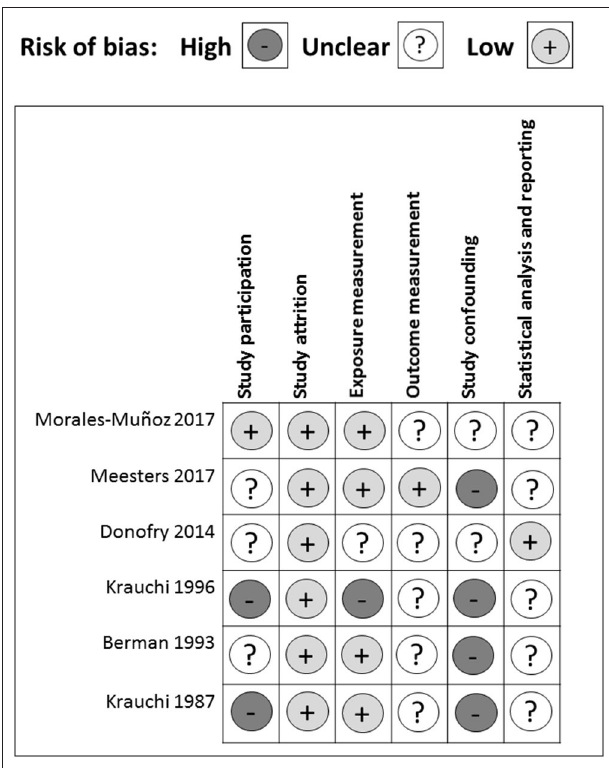
FIGURE 3 | Risk of bias assessment for observational